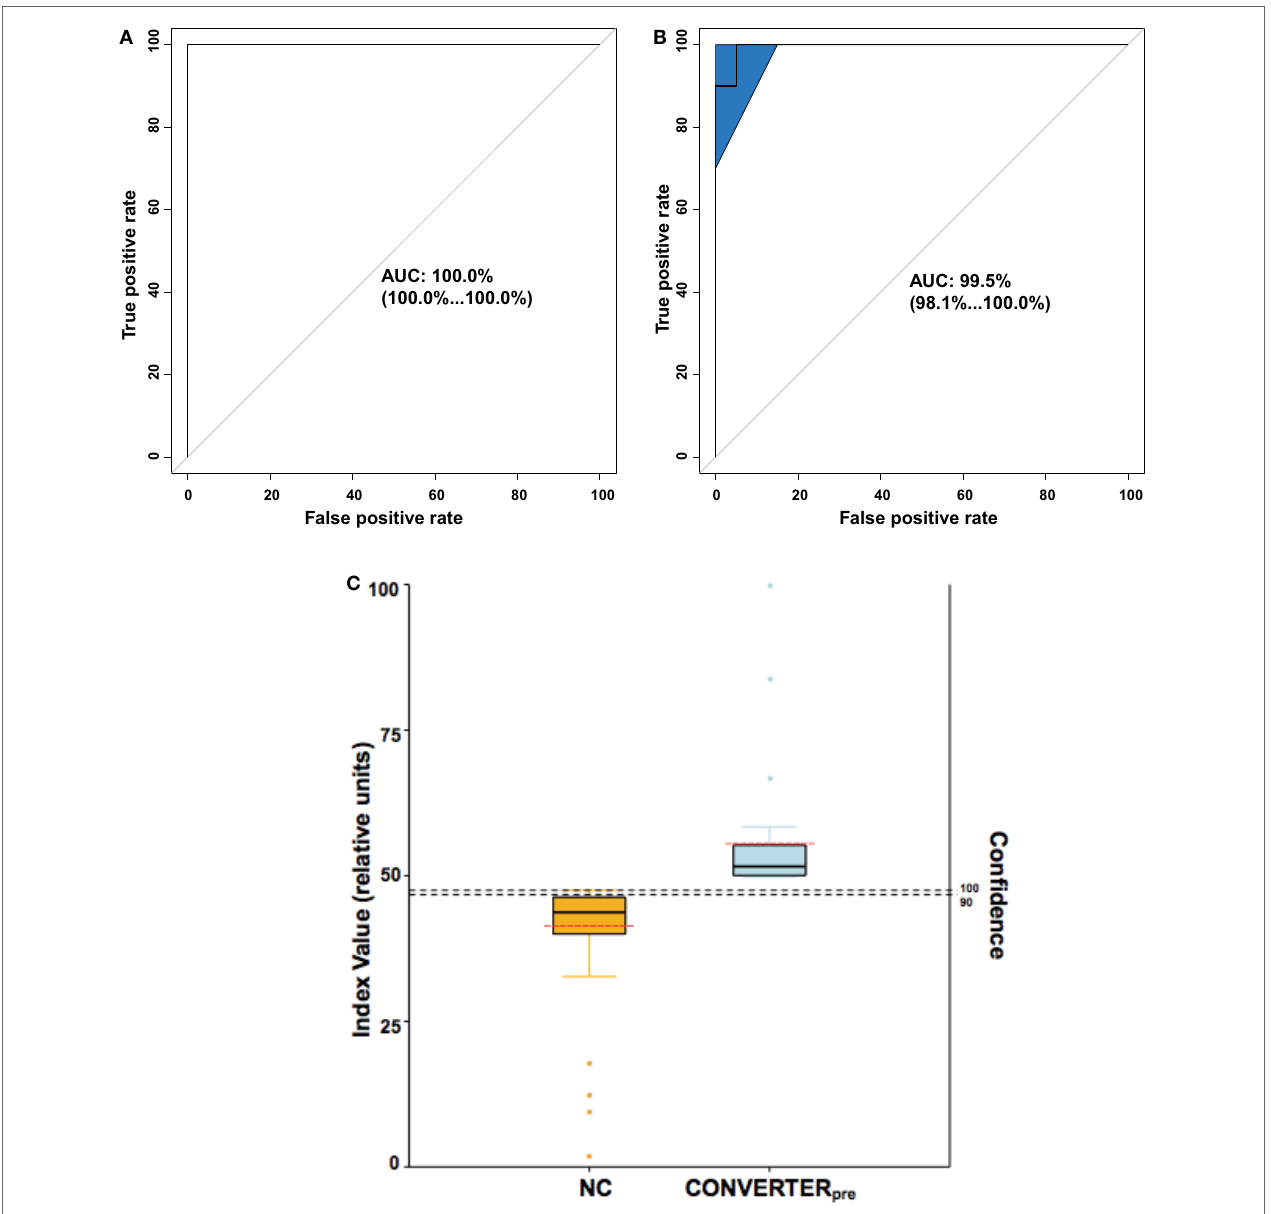
FigUre 4 | analytic representations to discriminate converter pre from normal control (nc) subjects . (a,B) provide receiver operating characteristic (ROC) curves, whereas (c) depicts the calculated plasma 24 metabolite index (P24MI). (a) ROC area under the curve (AUC) for the Discovery cohort was equal to 1.00 with 95% confidence interval (in parentheses) ranging from 1.00 to 1.00. (B) ROC AUC for the internal validation cohort was 0.995, with 95% confidence interval (shaded area on plot) ranging from 0.981 to 1.00. (c) The P24MI results are depicted in vertical boxplots based on the logistic regression model that distinguishes between Converter pre and NC groups. Solid black horizontal lines represent the mean value, while the dashed red horizontal lines represent the median value. Orange and light blue dots represent outliers ( ≥ 1.5 IQR lengths from the ends of the box). The higher index values (left vertical axis) are associated with an increased risk of phenoconversion to aMCI or AD, as seen in our Converter pre subjects, with confidence (right vertical axis) of predicting phenoconversion transitioning from 90 to 100% at an relative index value of 48. Based on the calculated P24MI in our current dataset, a relative index value ≥ 49 represents a Converter pre individual and a risk of phenoconversion of 100% within the 5-year study range. Note the relatively low variability of the P24MI for both the NC group and the Converter pre group, with no